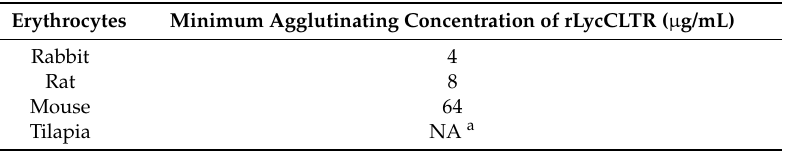
Table 2. Hemagglutinating activity of rLycCTLR on animal erythrocytes.